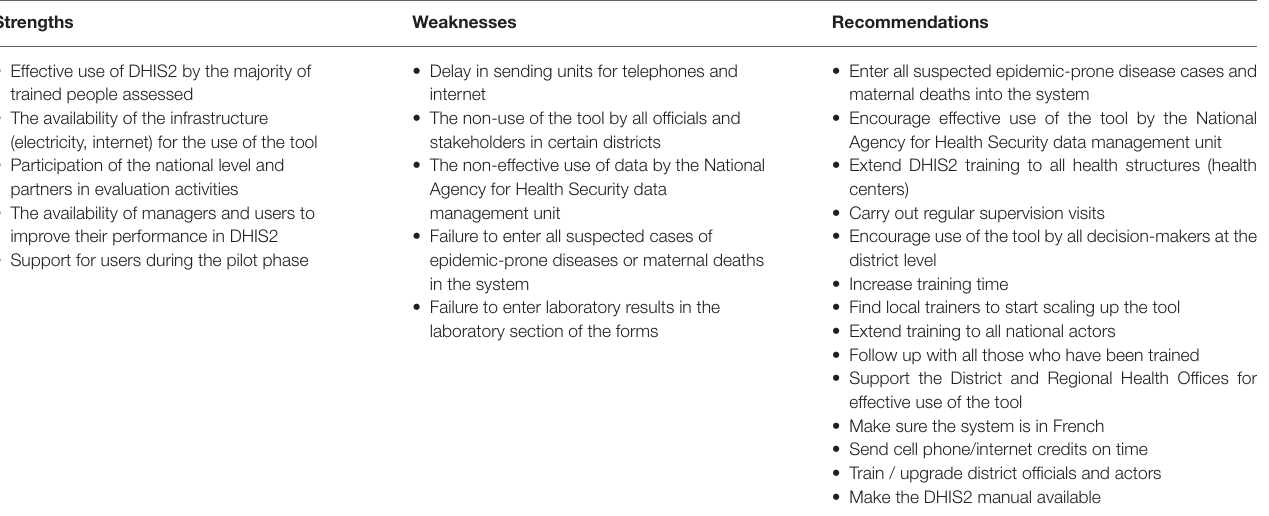
TABLE 4 | Summary of strengths, weaknesses, and recommendations from the evaluation of the pilot phase.